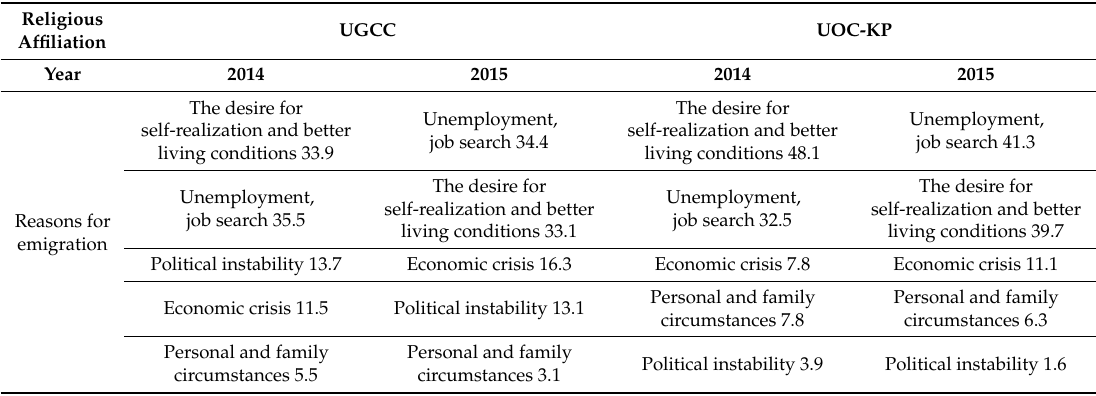
Table 2. The answers of the Ukrainian Greek Catholic Church (UGCC) and Ukrainian Orthodox Church of the Kyiv Patriarchate (UOC-KP) believers to the questions about the conditions that may encourage traveling abroad (data from 2014 and 2015), in